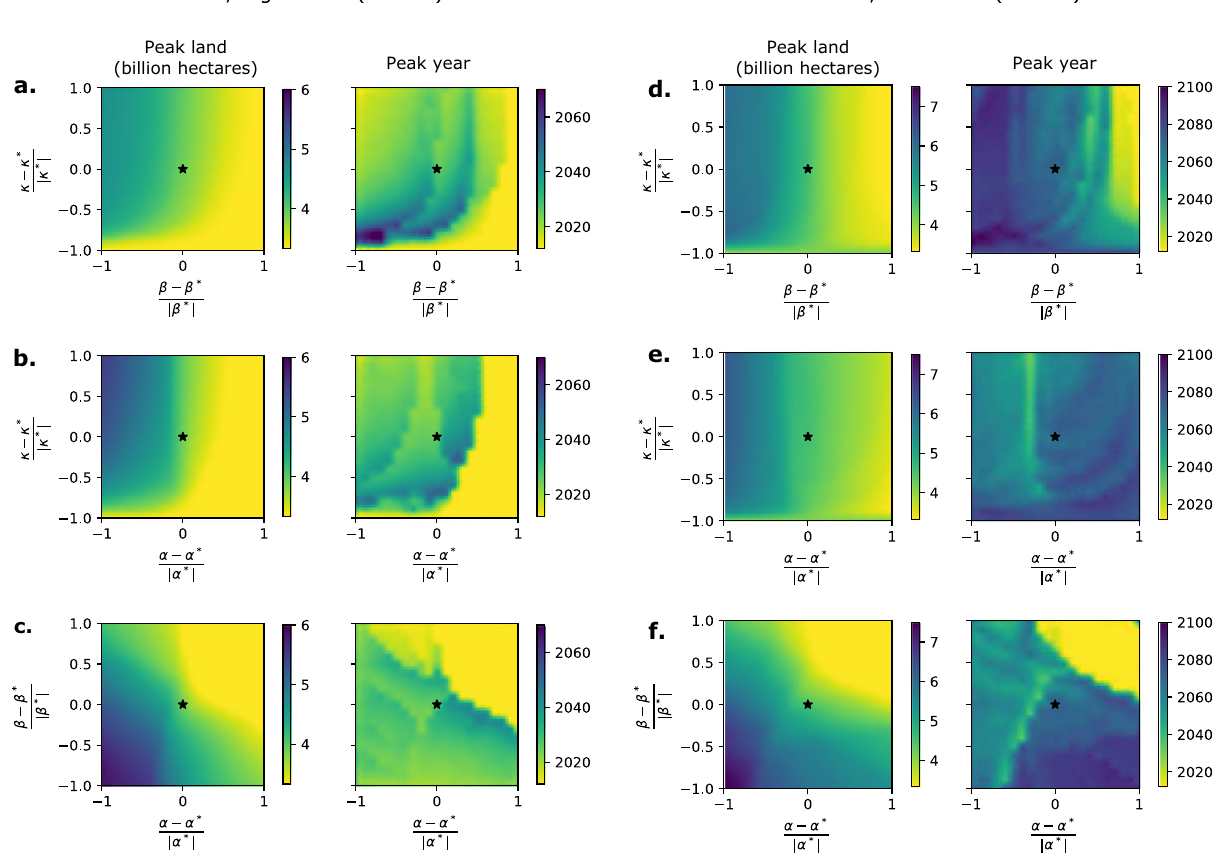
Fig. 4 Model projections with parameters deviated from the baseline setting highlight the impact of consumptional behavior and socio-economic factors on global land-use trajectories till 2100. Model projections of peak global land use and corresponding peak year are shown for parameters deviated from the baseline setting. Results are shown for the population and income scenario of SSP2 at the yield scenarios of f = 0.2 (panels a – c ) and f = 0.8 (panels d – f ). For comparison across SSP scenarios see Supplementary Fig. 10. For each contour plot, we vary two out of three parameters from their baseline setting while keeping the third fi xed at the baseline setting. In panels a , d , we vary κ i (social learning rate) and β i (income net bene fi ts of the eco- conscious diet) from the baseline values while keeping the values of α i (non-income bene fi ts of the eco-conscious diet) fi xed at the baseline level. For panels b , e , the parameter values of β i are kept constant at the baseline level. In panels c , f , the parameter values of κ i are kept constant at the baseline level while the other two remaining parameters are varied. The values of parameters are changed within − 100% to 100% of their baseline value. The variables κ * , α * , and β * represent the baseline parameter values for the countries as estimated from the parameter estimation process. During projections, equivalent change is made to the baseline parameters of all countries. The black star in each contour plot represents the baseline setting. Peak year is de fi ned as the year in which peak global land use is achieved during the